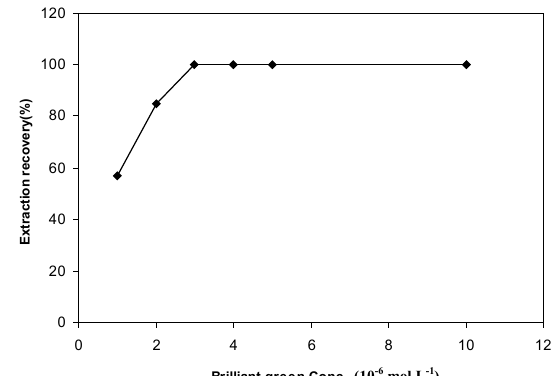
Figure 2. Effect of brilliant green concentration on the extraction recovery of of Au (100 ng mL -1 ), 0.05% (v/v) Triton X-114, 0.1 M hydrochloric acid.